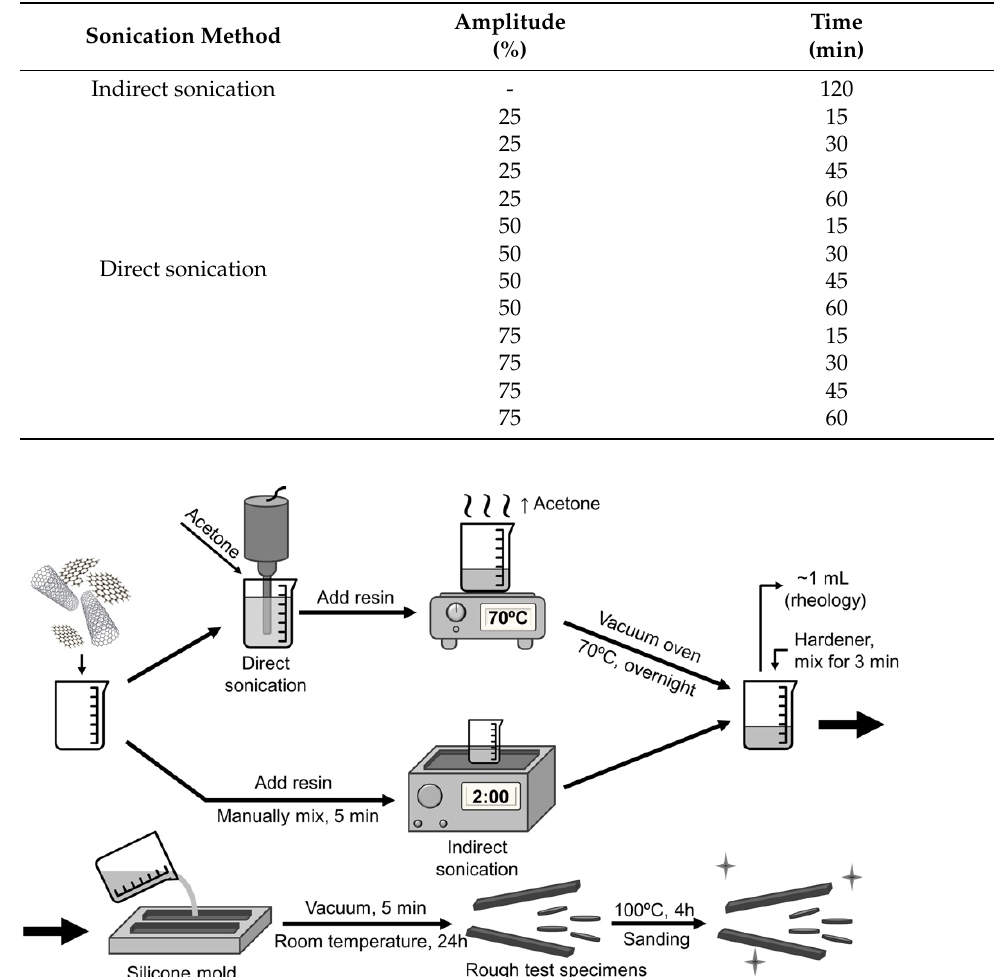
Table 1. Sonication parameters used for preparing GNP-, CNT- and hybrid-filled nanocomposites.